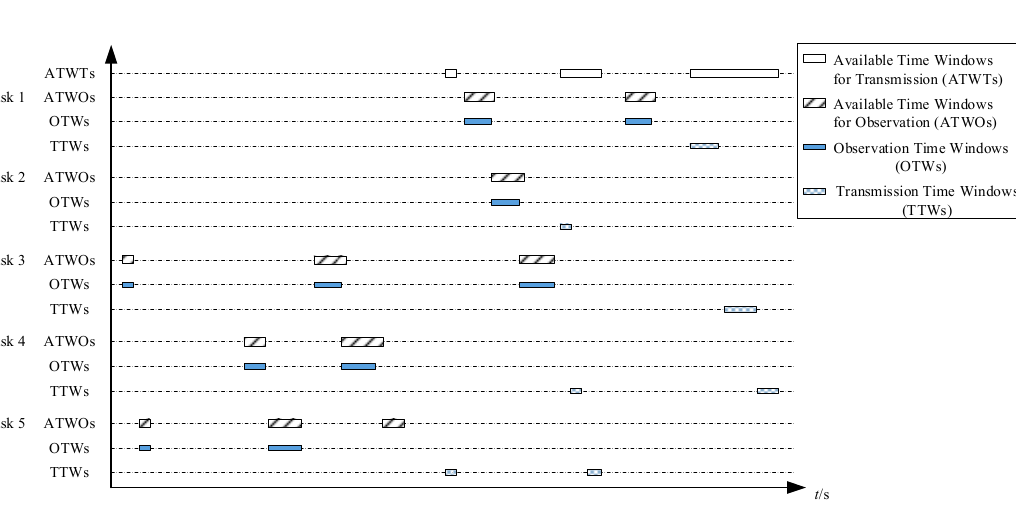
Figure 8. Example of time window scheduling. Table 7. Effectiveness evaluation.